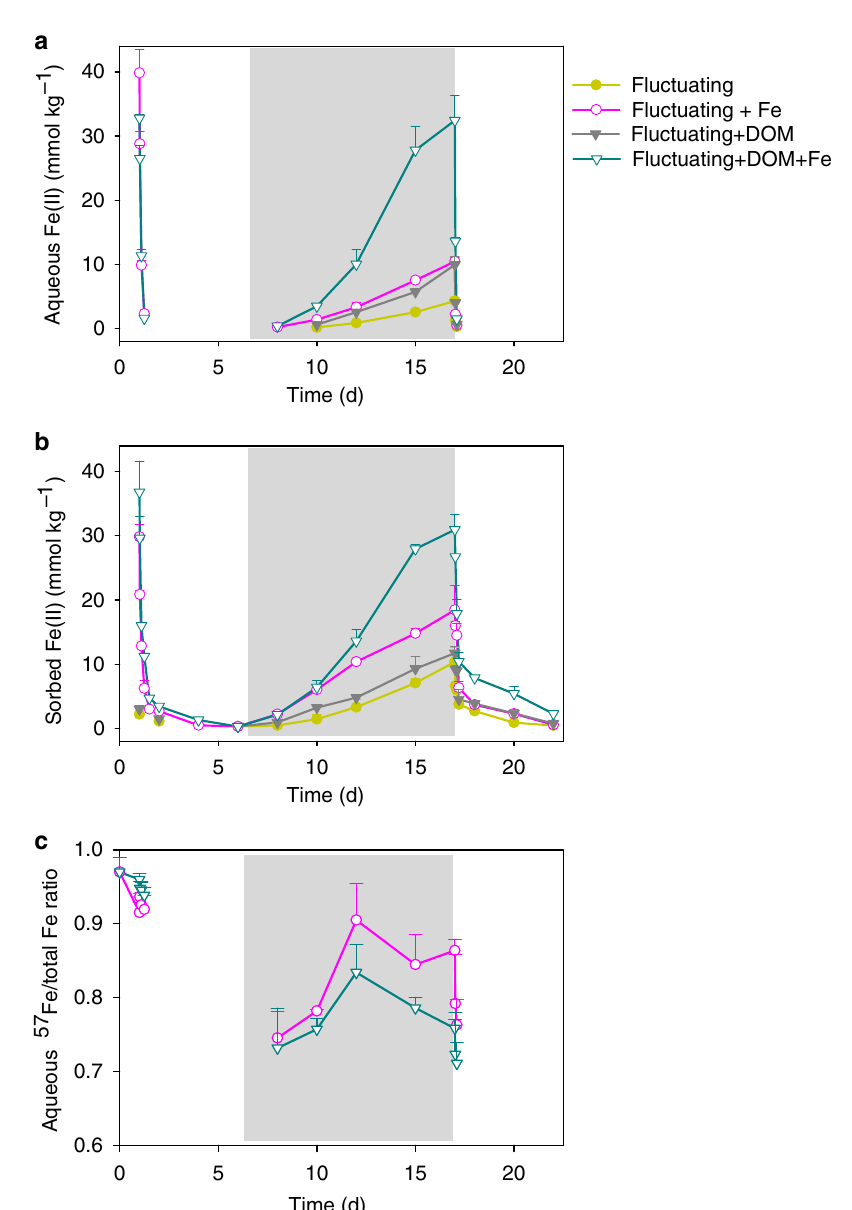
Fig. 2 Fe II concentration and 57 Fe to total Fe ratio. Time-dependent a aqueous Fe II , b sorbed (HCl-extractable) Fe II , and c dissolved 57 Fe to total Fe ratio in the aqueous phase in the redox- fl uctuating treatment. Fe II and 57 Fe were undetectable during day 1.5 – 6 and 17.5 – 22. The gray shaded region represents the anoxic phase of the redox- fl uctuating treatment. Error bars indicate s.e.m. ( n =